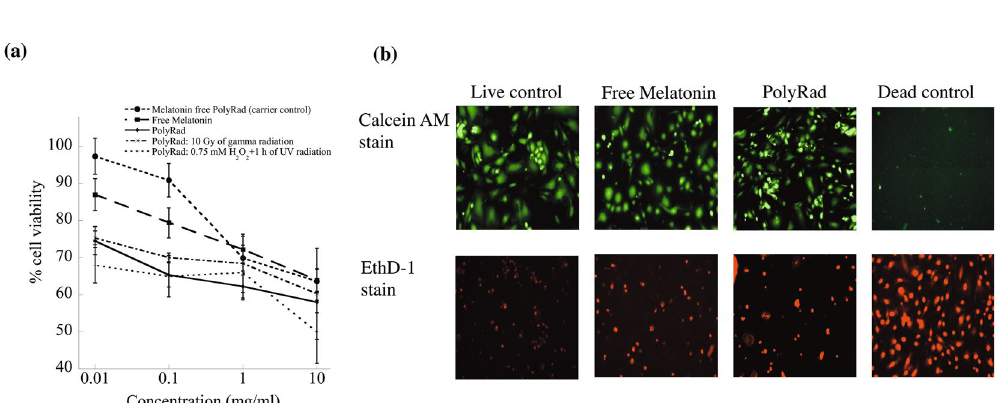
Figure 8. In vitro release profiles of melatonin from PolyRad. ( a ) In vitro release curves of melatonin from PolyRad in PBS of pH 7.4 at 37 °C before (open circle, dotted line) and after the photochemical degradation (solid circle, solid line) of PolyRads. (b) Melatonin release data were fitted to power law models before and after photochemical degradation of PolyRads. The column bar represents the mean value with standard deviations for n = 3 independent experiments.